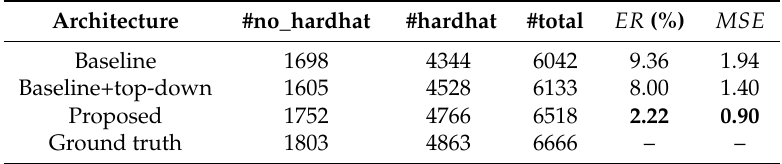
Table 6. People-counting results of different network architectures on the test set. ER: error rate; MSE: mean square error (bold indicates either best performance or minimum